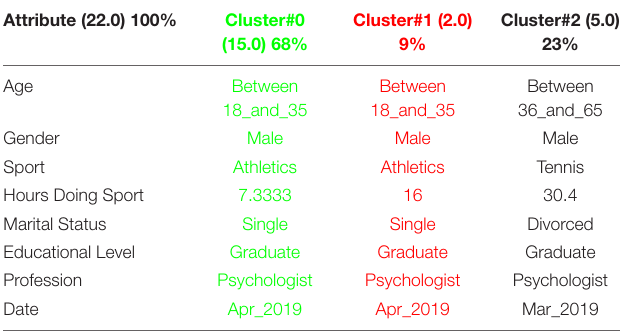
TABLE 7 | 3 clusters RS analysis for March to May 2019.